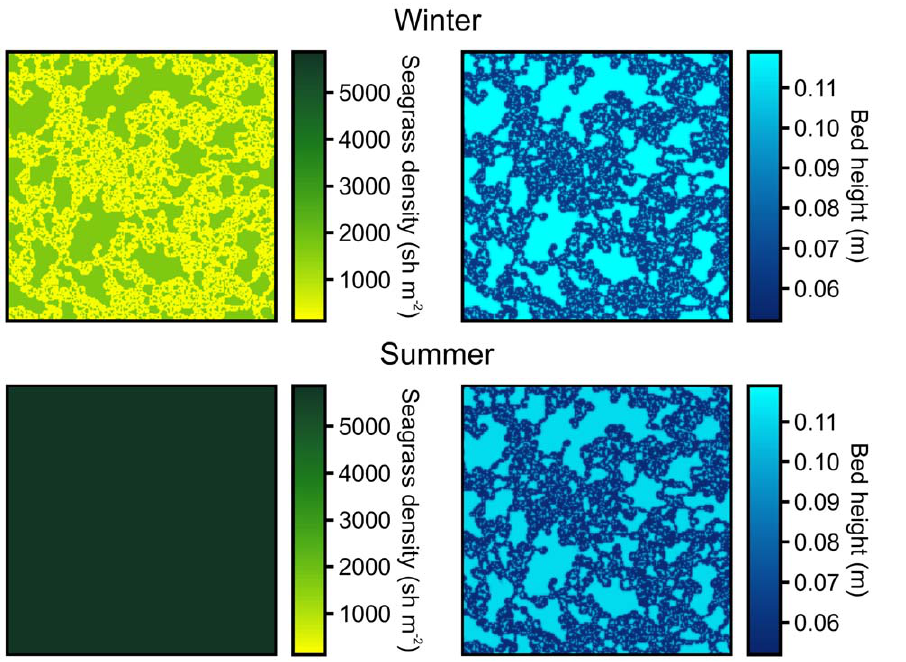
Figure 3. Model simulations at defaults settings demonstrated that interactions between sediment accretion by seagrass and selective grazing of low parts by waterfowl in autumn could indeed explain the observed temporal and spatial patterns in the field.